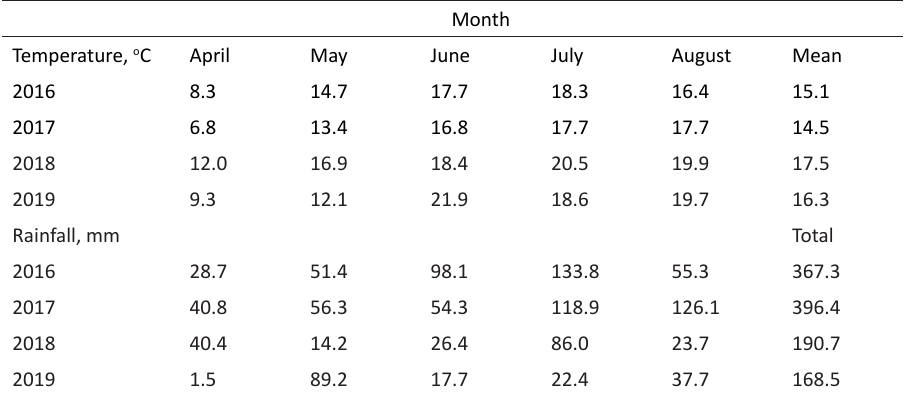
Table 2. Weather pattern in